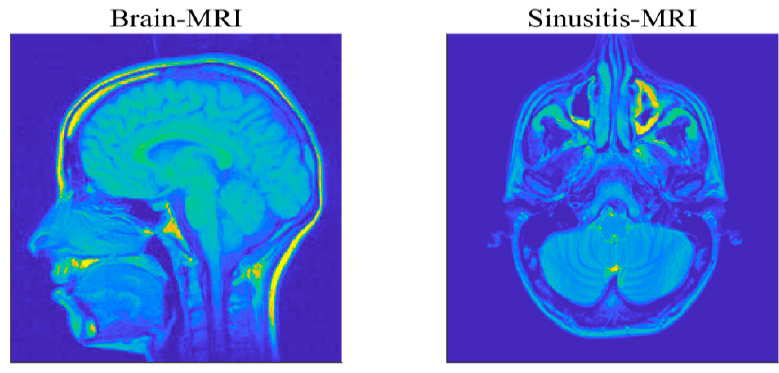
Figure 12. Two test MRI images.